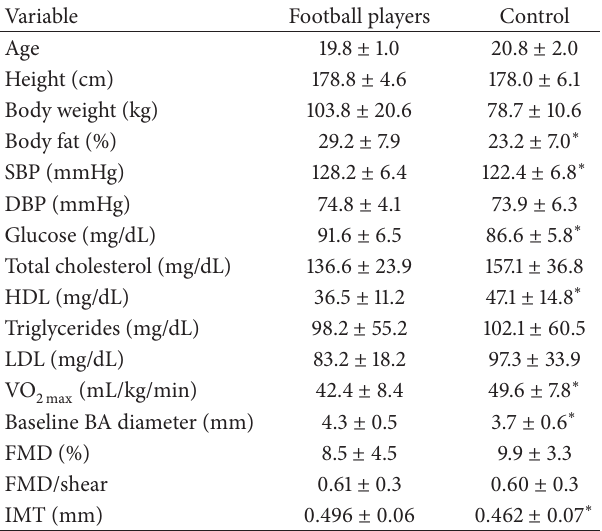
Table 1: Comparison between football players and